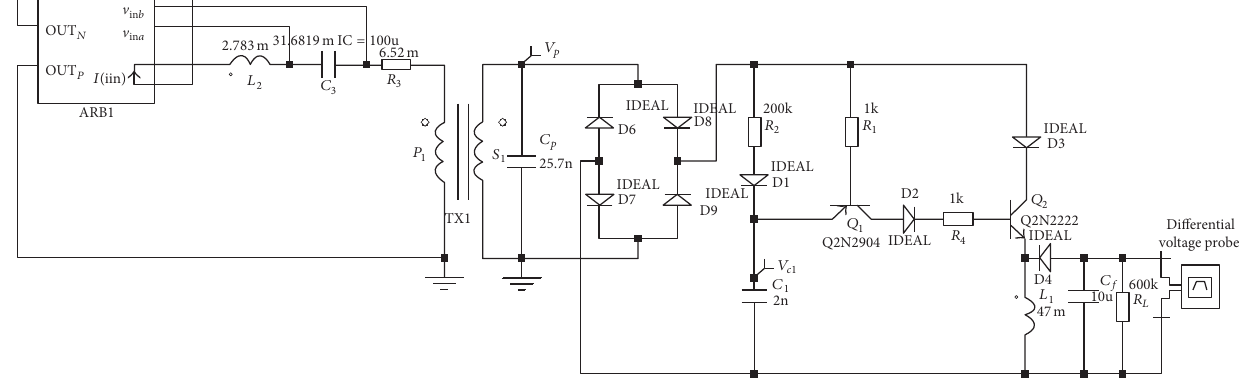
Figure 5: Schematic of self-powered SCE circuit integrated with a galloping piezoelectric energy harvester [33].